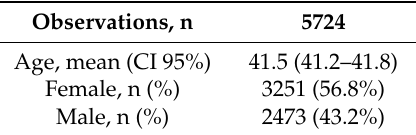
Table 3. Basic description of the